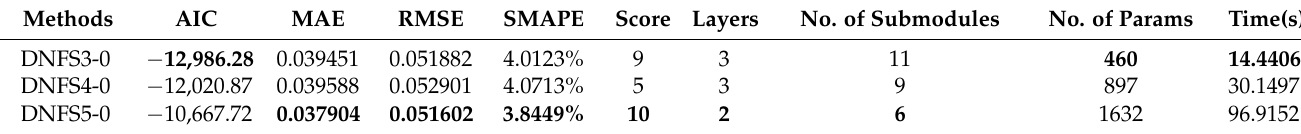
Table 2. The performance of DNFSs with different submodule inputs on Test Dataset No. 1 .